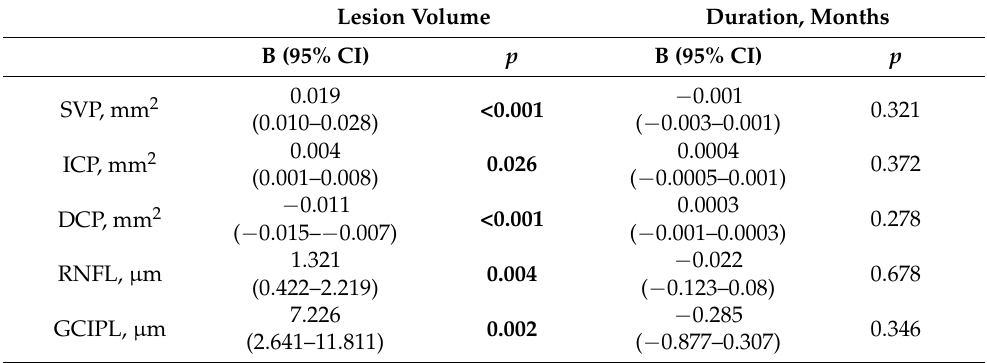
Table 4. Correlation of lesion volume and duration with SS-OCT/SS-OCTA parameters in patients.